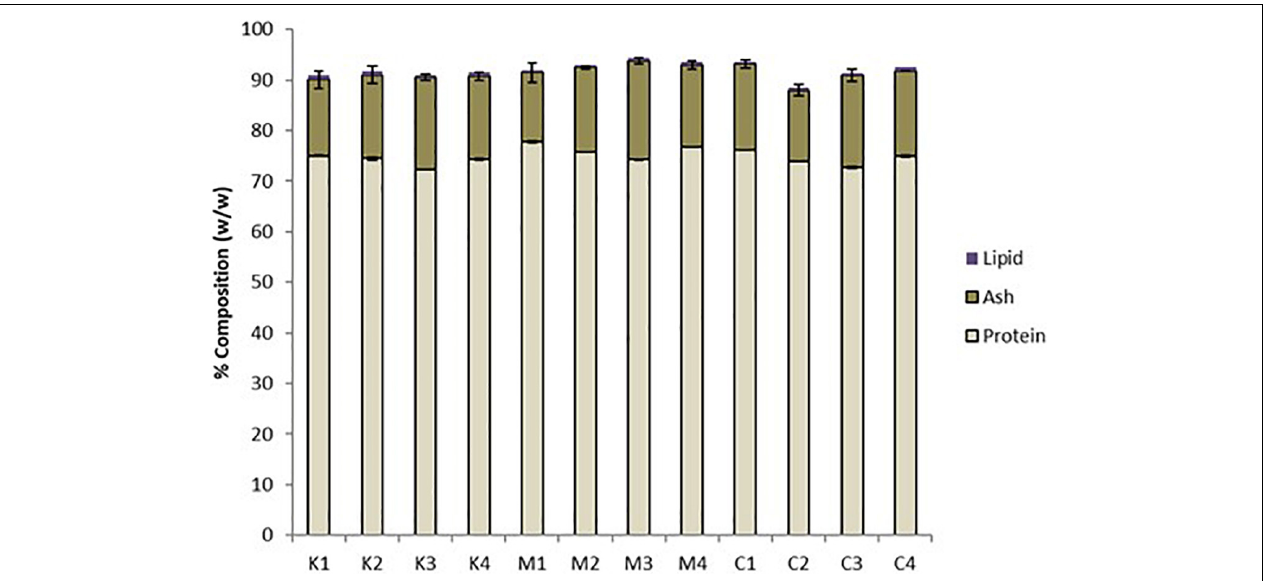
FIGURE 1 | Proximate composition of mesopelagic Hydrolysates derived from Krill (K), M. muelleri (M), and a combination of Krill and M. muelleri (C) by method 955.04 (Association of Official Analytical (AOAC), 2000; n = 3). One way ANOVA using Tukey’s multiple comparison test at α = 0.05 showed no significant differences between protein, ash, and lipid content of the 12 mesopelagic Hydrolysates.